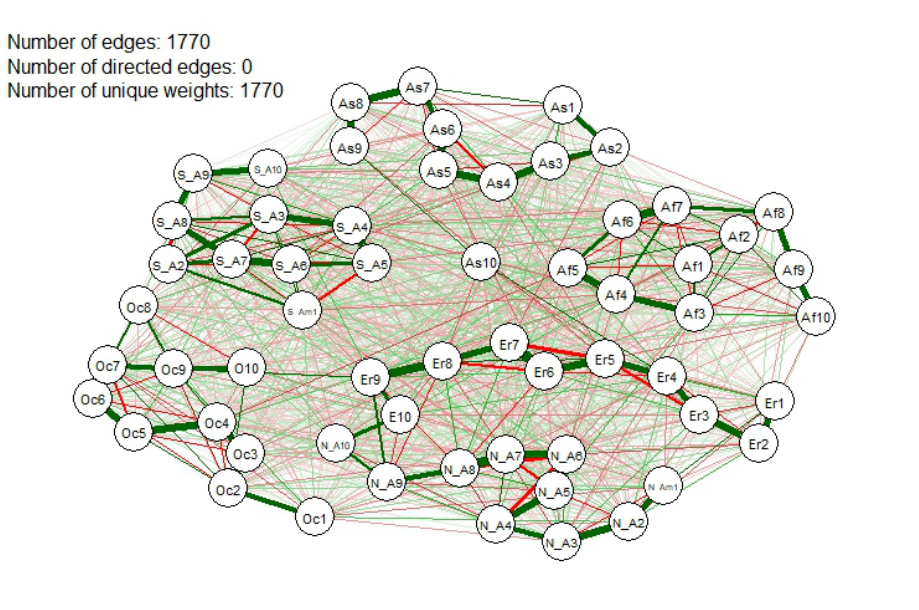
Figure 2. Unregularized Partial Correlation